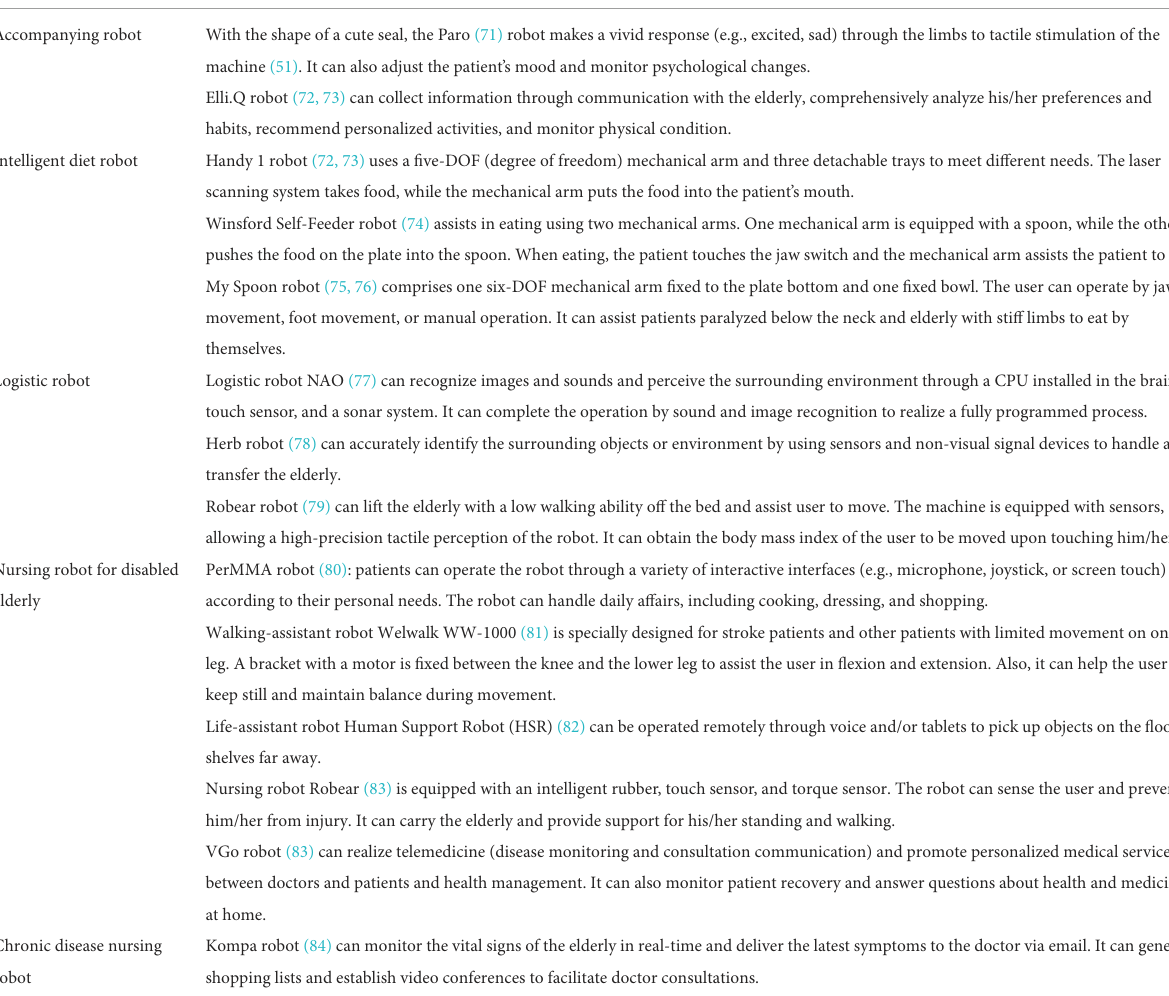
TABLE 1 Different types of home nursing robots. AI robots in